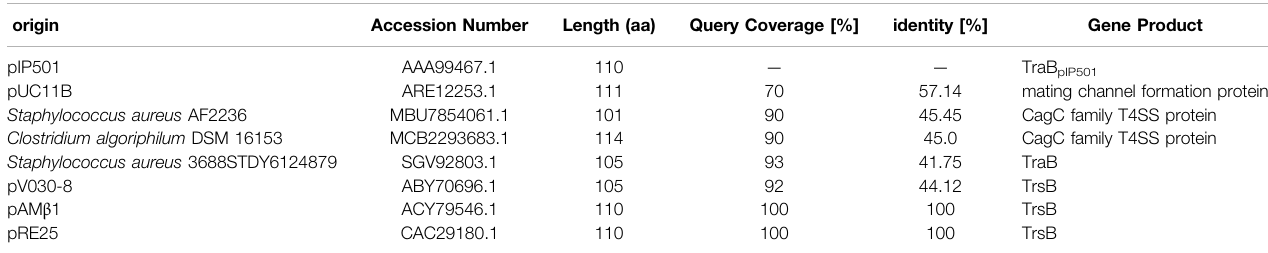
TABLE 1 | TraB pIP501 and its orthologs found with PSI-BLAST using the NCBI